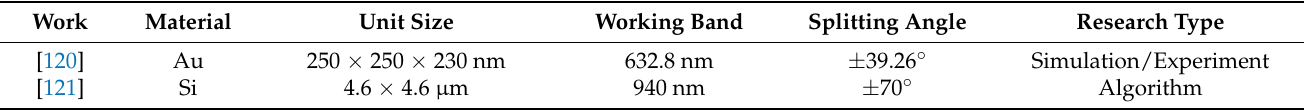
Table 5. Parameters of non-polarizing metasurface beam splitters described in this